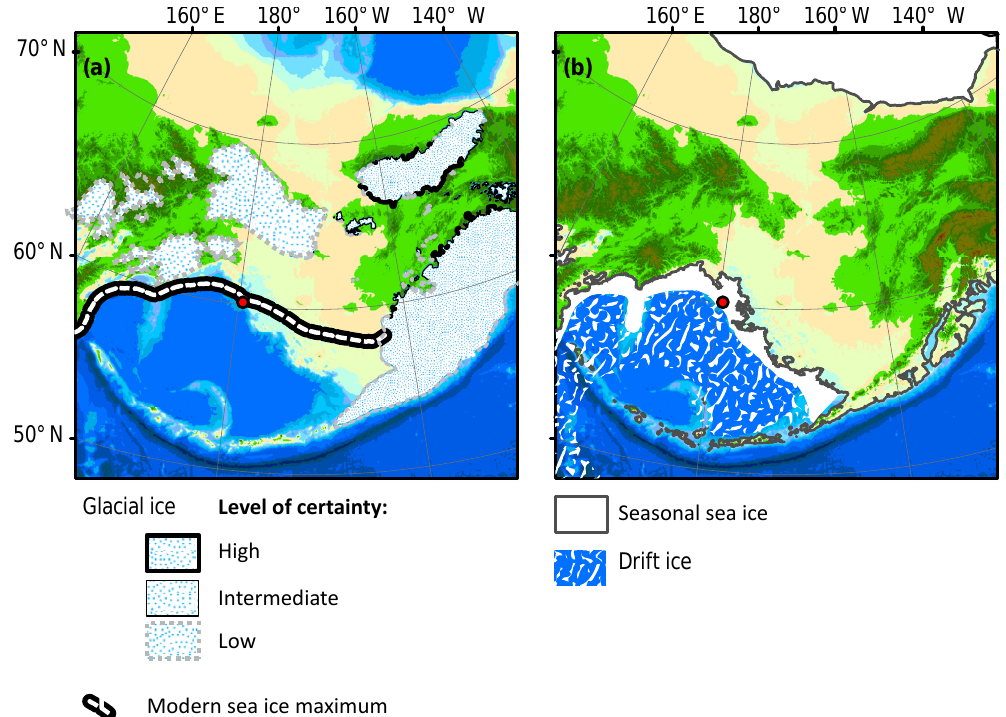
Figure 2. Maximum glacial and sea ice extents in Beringia. Panel (a) depicts the maximum glacial ice in Beringia as inferred from terminal and lateral moraines (Gualtieri et al., 2000; Heiser and Roush, 2001; Kaufman, et al., 2011; Barr and Clark, 2009). This is not intended to show the maximum extent during a particular glaciation but rather the maximum possible extent of glacial ice. These moraines are likely from several different major glaciations. The level of certainty is indicated by the thickness of the line at the moraine. The white-and-black dashed line is the maximum extent of sea ice (median over period 1979–2013) (Cavalieri et al., 1996). Panel (b) depicts the approximate pattern of sea ice during glacial stages (Katsuki and Takahashi, 2005). The dark-grey contour is − 140ma.p.s.l., the approximate sea level during MIS 12 (Rohling et al., 2010). Base map is modified from Manley